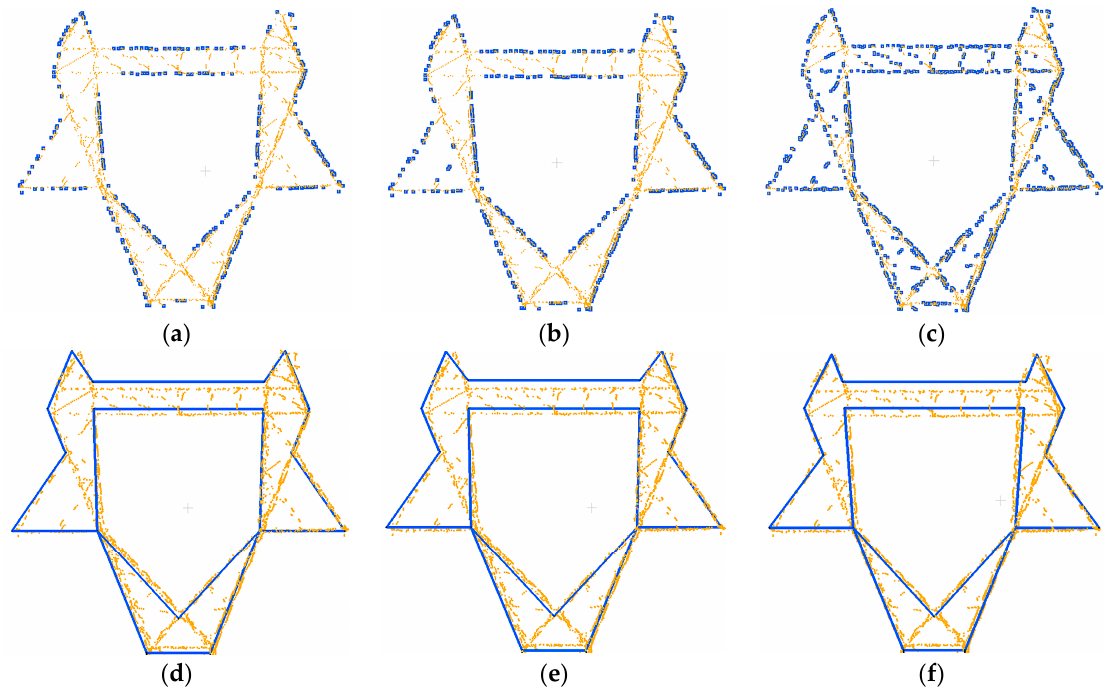
Figure 15. Key point extraction and head reconstruction result: ( a – c ) the extraction results of alpha = 1 m, 0.5 m, and 0.1 m, respectively; and ( d – f ) the corresponding head reconstruction results.